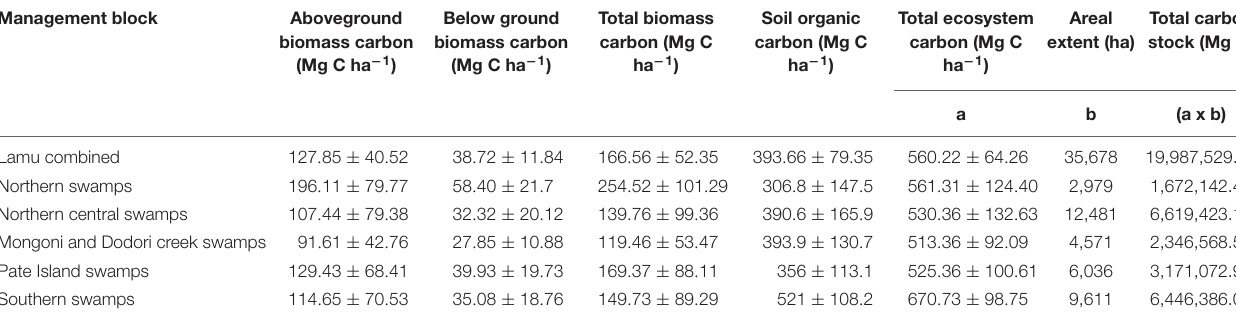
TABLE 5 | Total ecosystem C stocks of mangroves in Lamu (mean ±